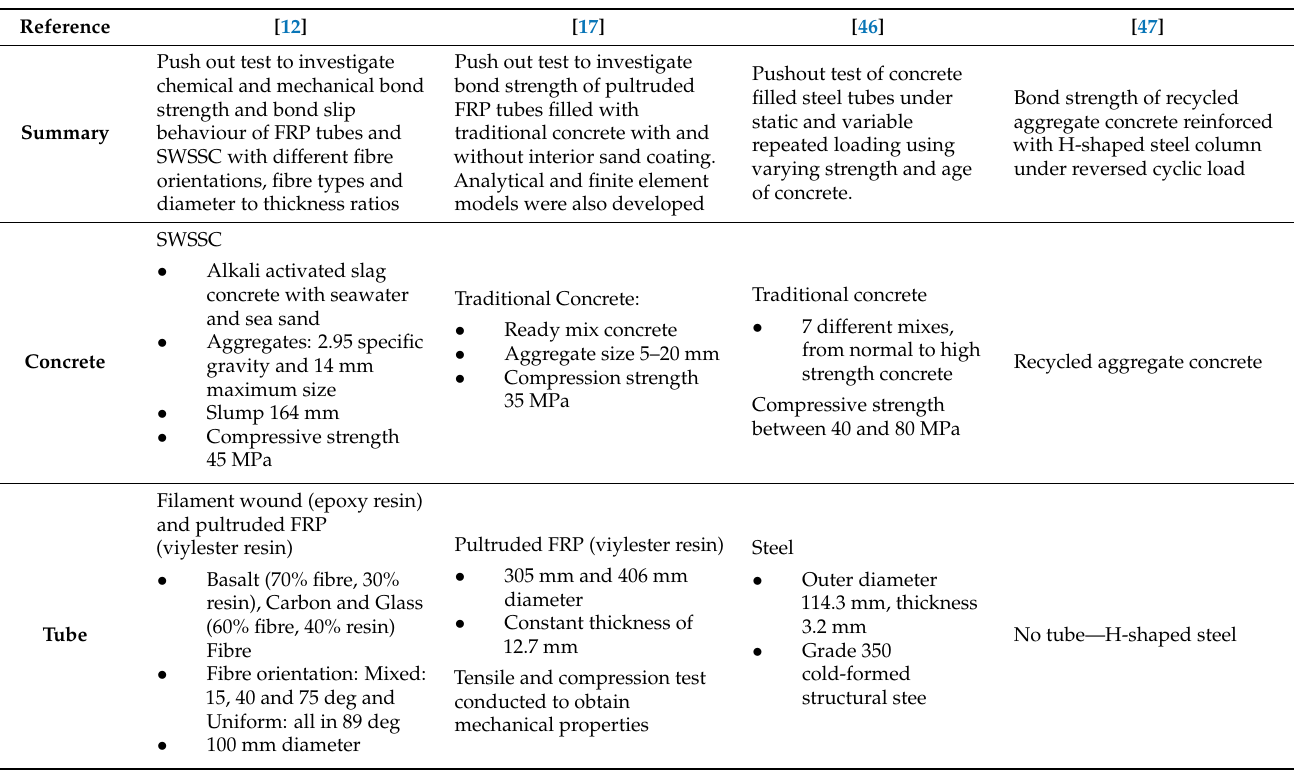
Table 3. Overview of relevant recent bond-strength